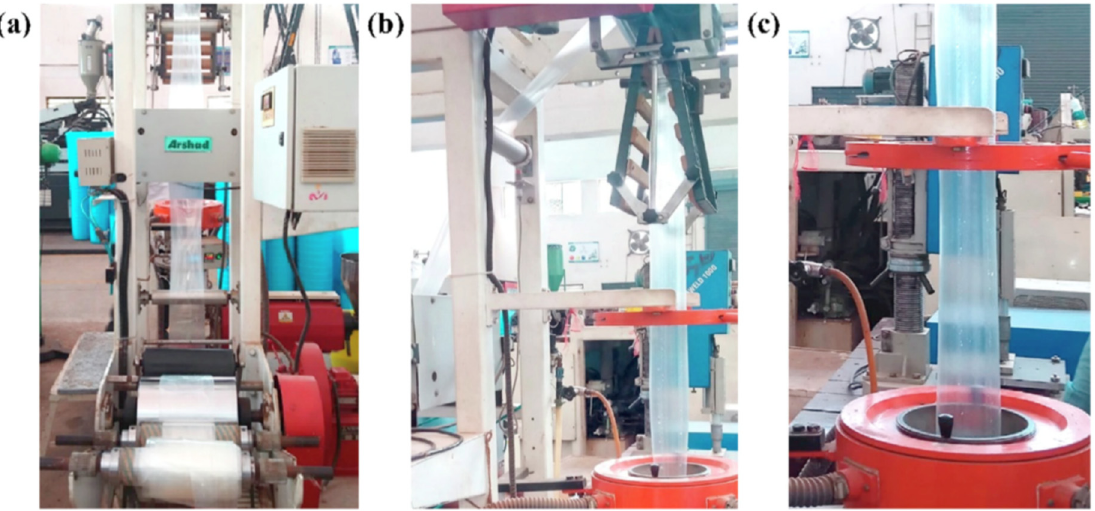
Figure 13. Industrial scale setup of the film blowing process: ( a ) Calendaring of the neat PLA film and ( b , c ) the blown film of the 1% PLA/MgO nanocomposite [194].